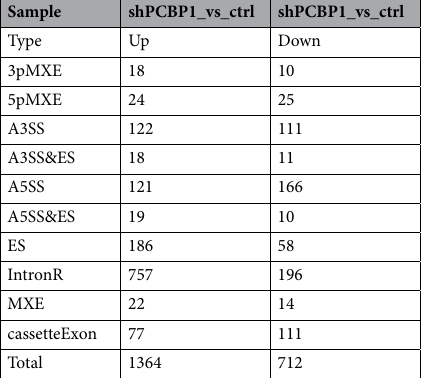
Table 4. Classification of all RASE events between sample groups. RASE regulated alternative splicing events, PCBP1 poly C binding protein 1, 3pMXE mutually exclusive 3 ′ UTRs, 5pMXE mutually exclusive 5 ′ UTRs, A3SS alternative 3 ′ splice site, ES exon skipping, A5SS alternative 5 ′ splice